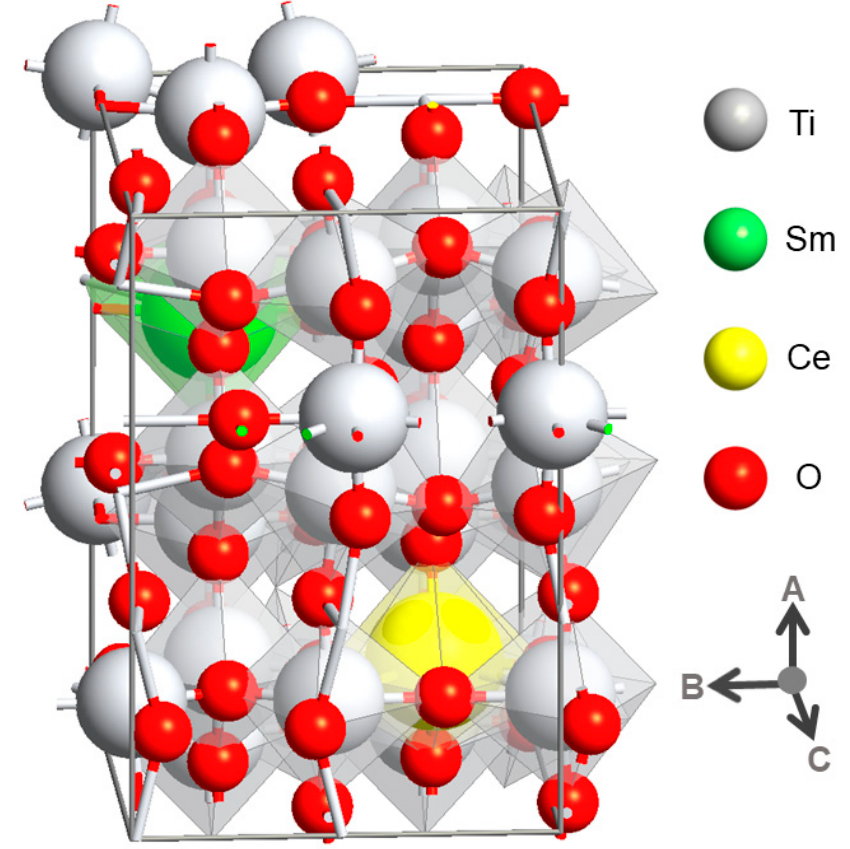
Figure 5. Unit cell of Ce–Sm co-doped TiO 2 nanomaterial composed of 72 atoms. The total density of states (DOS) for both pristine TiO 2 and Ce–Sm co-doped TiO 2 NPs is illustrated in Figure 6a,b, respectively, where the Fermi energy ( E F ) is adjusted to zero. The DOS spectra, providing information about the electronic structure, demonstrate that the spin-up (positive variation) and spin-down (negative variation) states are identical. Ce and Sm atoms bring about additional states around the E F , modifying the Ce–Sm co-doped TiO 2 (cid:48) s electronic structure properties. This indicates that electronic characteristics can be tuned by the addition of RE atoms, resulting in the alteration of the energy bandgap ( E g ). Using the difference between the valence band maximum (negative energy) and conduction band minimum (positive energy), it can be obtained from the DOS spectra, as shown in Figure 6a. TiO 2 ’s E g was calculated as 3.19 eV. Upon the addition of Ce–Sm dopants, E g decreases to 2.13 eV and impurity states emerge, as displayed in Figure 6b. Such a drop in E g is reasonable, as it was reported to be 2.20 eV in earlier experimental work [45] for the Ce-doped TiO 2 nanocrystals where the Ce concentration was 10%. It could be ascribed to factors such as the modification of the unit cell (provoking a change in lattice parameters) and new available states in the vicinity of E F (which lowers the band gap) owing to the incorporation of RE